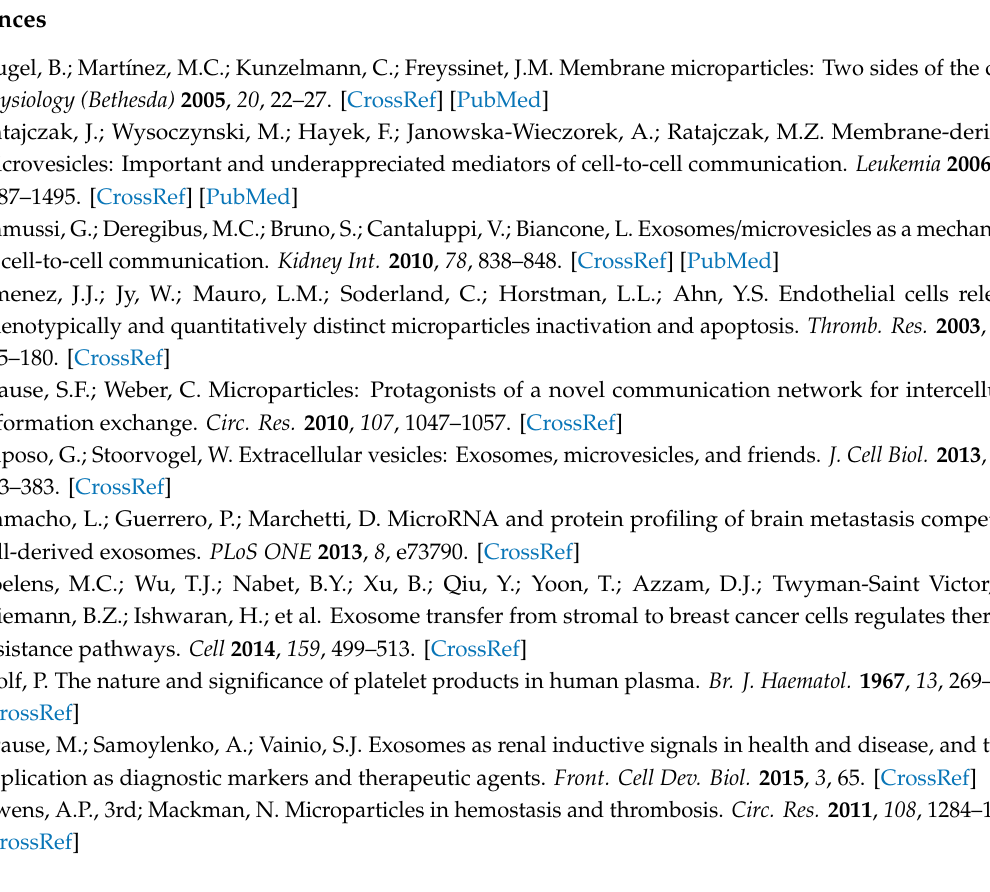
Figure S1: Specificity of M-NVs PHK26 staining. Figure S2: Fluorimetric assay to evaluate the uptake of Berberine (BBR) into T98G membranes-generated